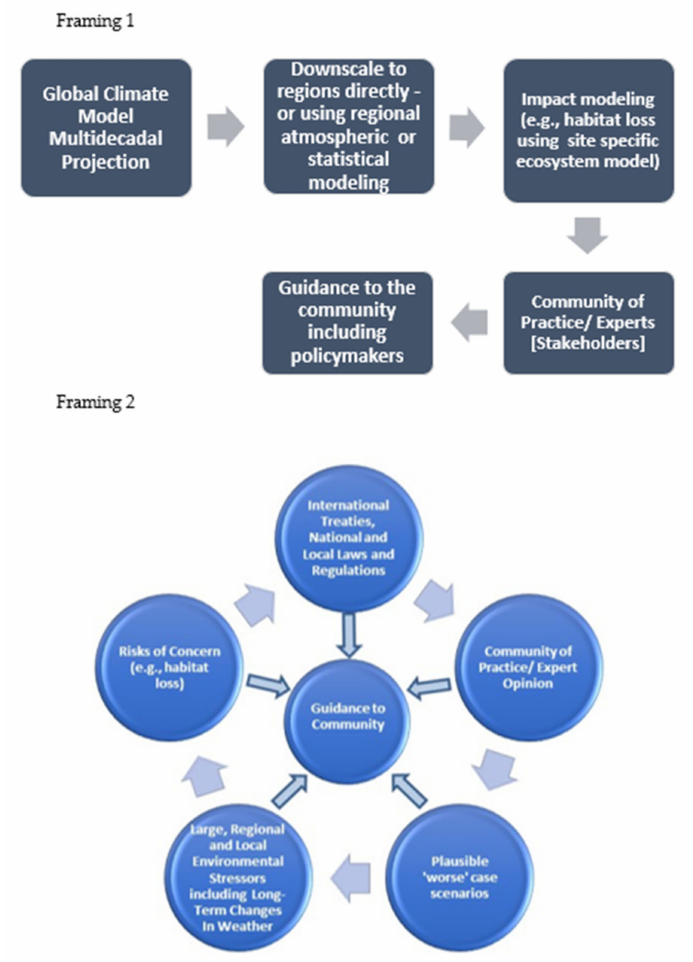
Figure 1. Schematic of framing of climate issue based on Hulme